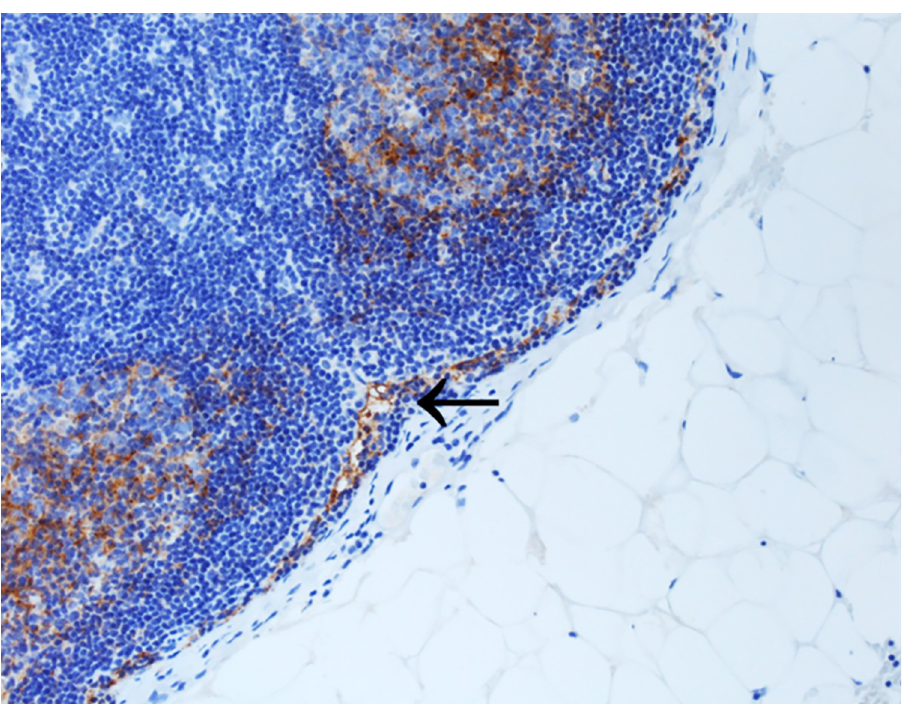
Fig 4. Staining pattern of D2-40 in the subcapsular sinus of a representative lymph node. In a SLN without metastasis the subcapsular sinus displays strong staining positivity of the sinus endothelial cells for D2-40 (arrow). Also, positive follicular dendritic cells in the germinal center are depicted (200x magnification).